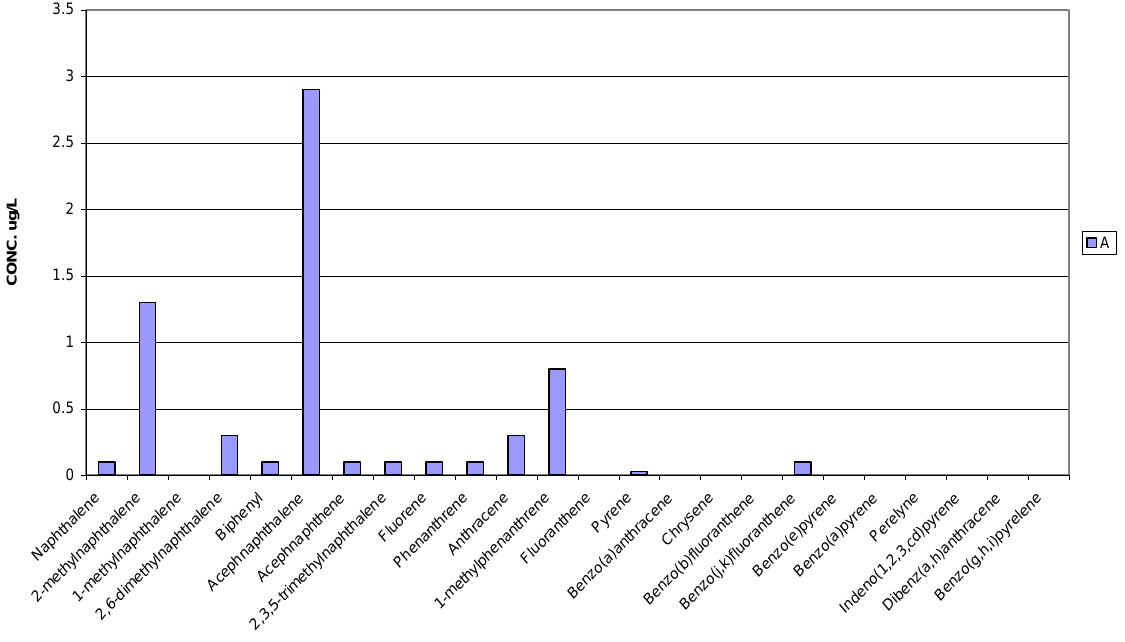
FIGURE 3. The average PAHs found in the Pra Estuary